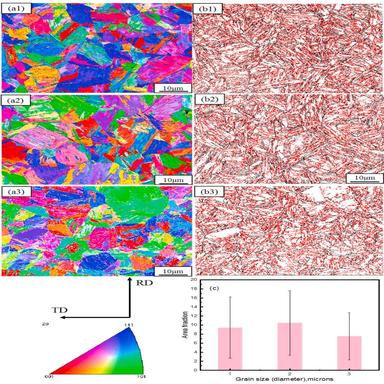
EBSD maps of TMCP steel (1), DQ steel (2) and QT steel (3). (a) Inverse pole figure (IPF) map, (b) grain boundary distribution, and (c) average grain size.